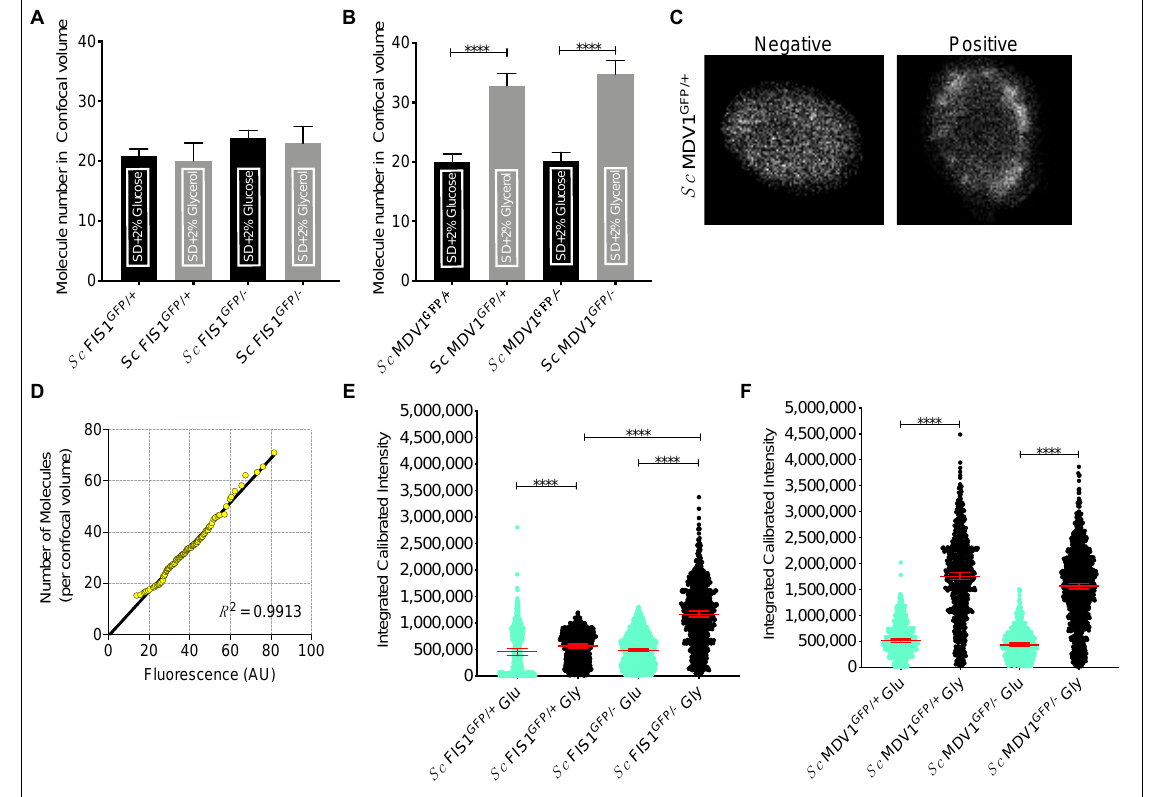
Figure 4. Cellular and mitochondrial-associated Fis1p-GFP and Mdv1p-GFP abundance. Comparison of the mitochondrial-associated Fis1p-GFP ( A ) and Mdv1p-GFP ( B ) abundance under different environmental and allelic perturbations. Images ( C ) showing Sc MDV1 GFP/+ cells: negative cells demonstrate even distribution of fluorescence across the cell; positive cells show mitochondrial localisation of fluorescence. Mitochondrial localisation was defined after comparison with cells carrying no fluorescence marker and stained mitochondria with Cox4p-DsRed. Sample of Quantile- Quantile plot of total and mitochondrial Fis1p-GFP protein distribution across their respective cell populations ( D ). Comparison of the integrated calibrated intensities of Fis1p-GFP ( E ) and Mdv1p-GFP ( F ) total cell abundance under different environmental and allelic perturbations. Error bars show the 95% confidence intervals and the median value. Statistical significance was calculated using Mann – Whitney two-tailed t -test. **** represents significance at the 0.0001 level.